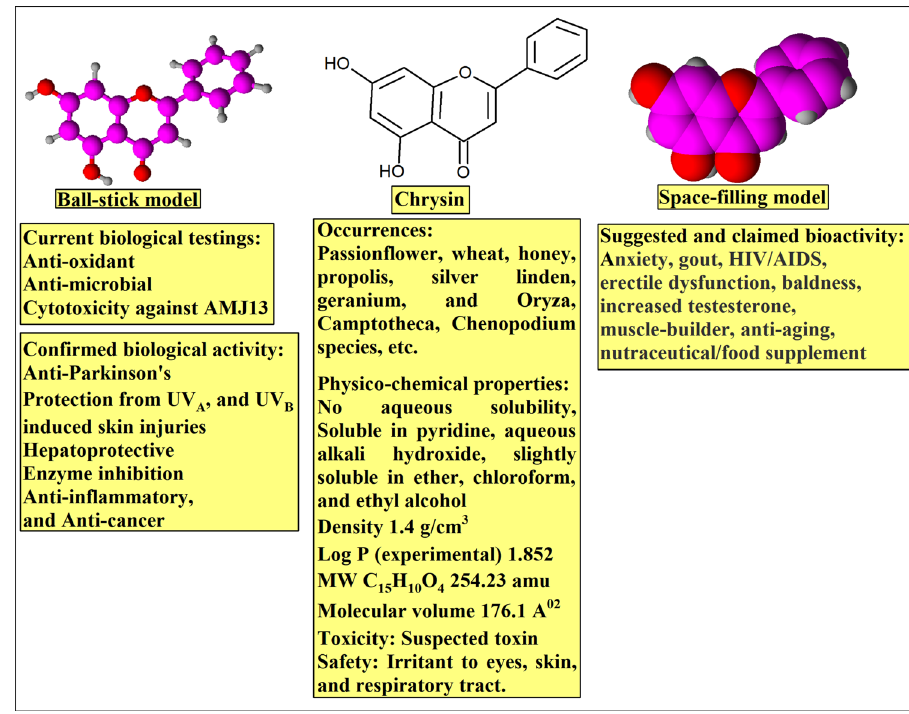
Figure 12: The CHR structure and properties: ball stick, space - fi lling models, physico - chemical, and biological